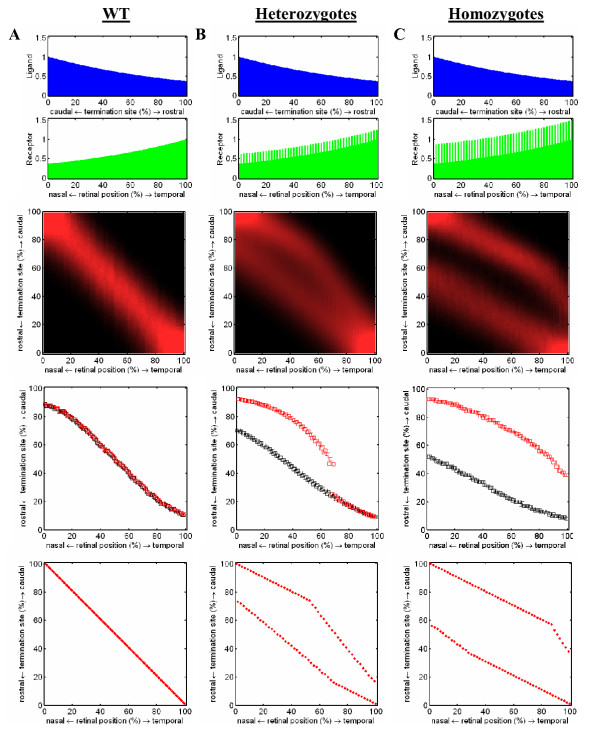
1D maps in wild-type and knock-in animals. A. column of results for wild-type conditions. B. Column corresponding to heterozygous Isl2/Eph3 knock-in conditions. The bifurcation of the probability distribution is similar to results of Ref. [20] (see Figure 2 above). C. Results for homozygous knock-in conditions. For all three conditions, the top row represents distributions of chemical labels. The second row shows the probability distributions. The brightness of color at each point in the middle image represents probability that an axon originating from the horizontal position projects to the point's vertical position. The bottom row shows positions of maxima of probability density distributions displayed above. The red squares correspond to wild-type cells; black markers determine maxima of distributions for Isl2+/EphA3+ RGCs. A slight even-odd oscillation observed in these panels is an artifact of ordering of wild-type and EphA3+ axons in retina. The bottom row shows maps obtained by sorting retinal receptor density.